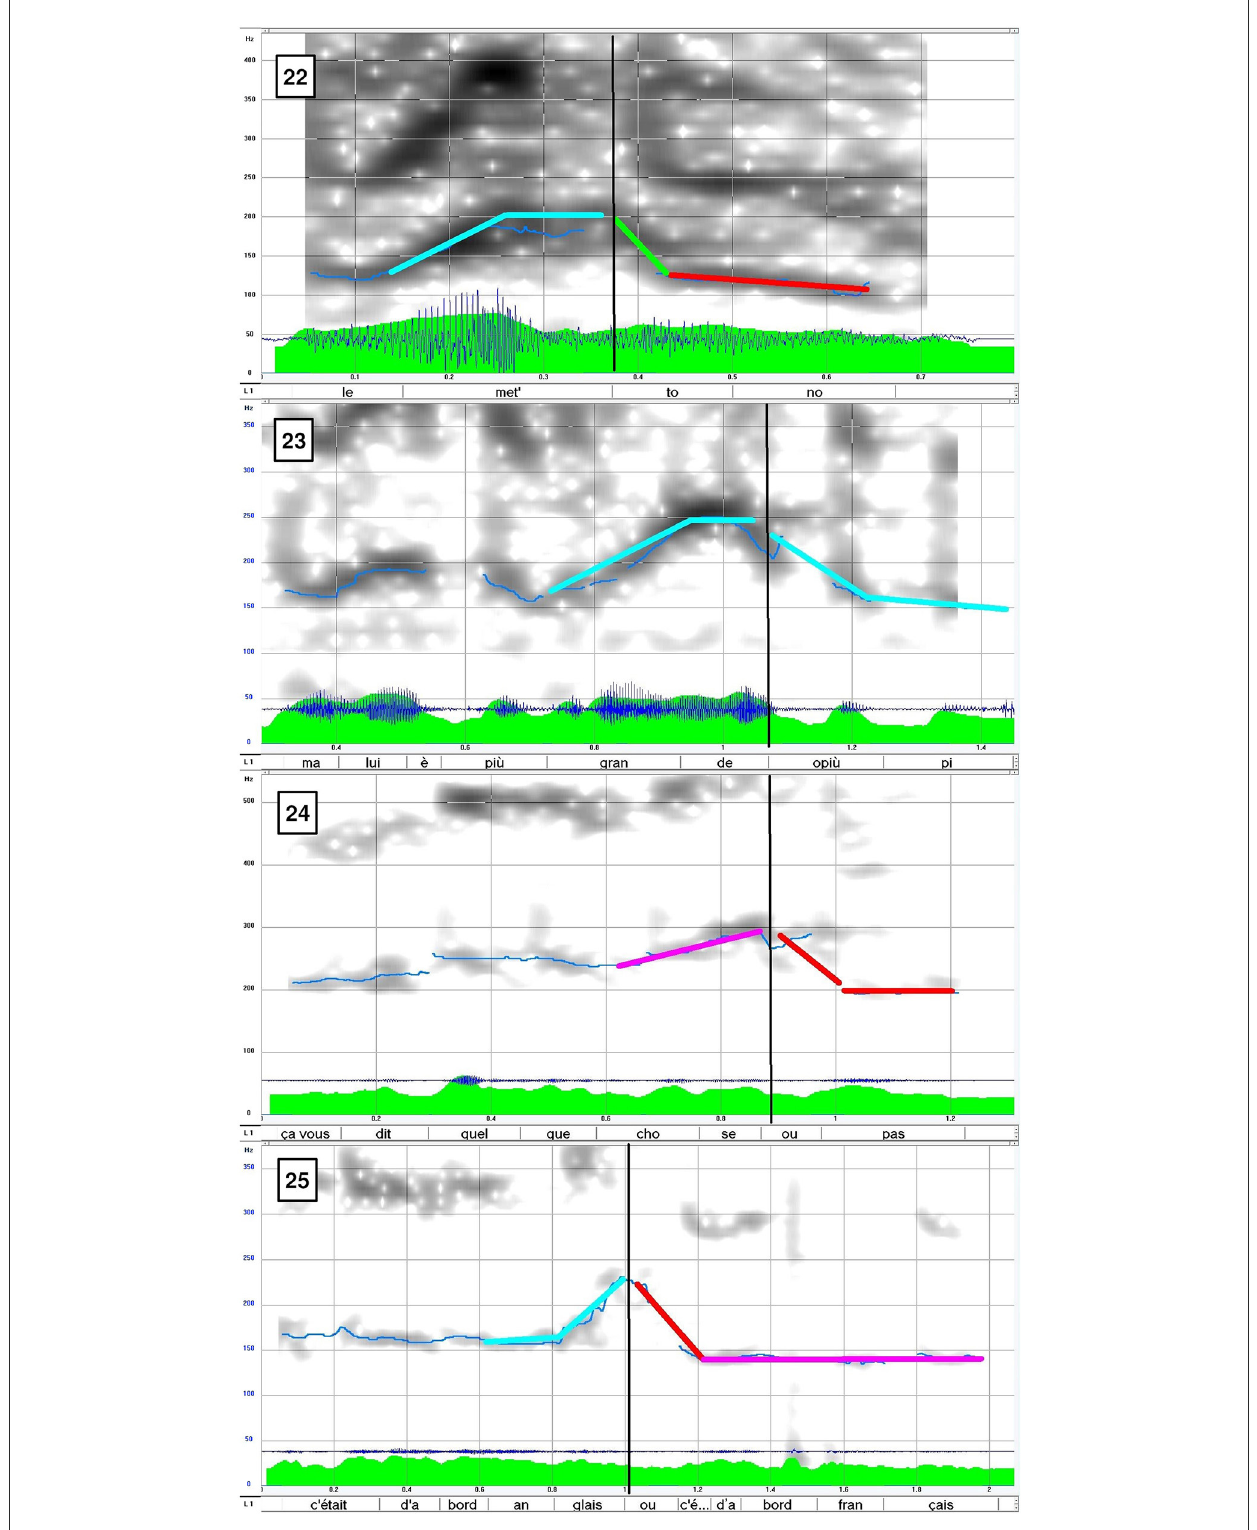
FIGURE13 Prototypic contours of Alternative questions in Italian and French (22–25) (Supplementary Audio